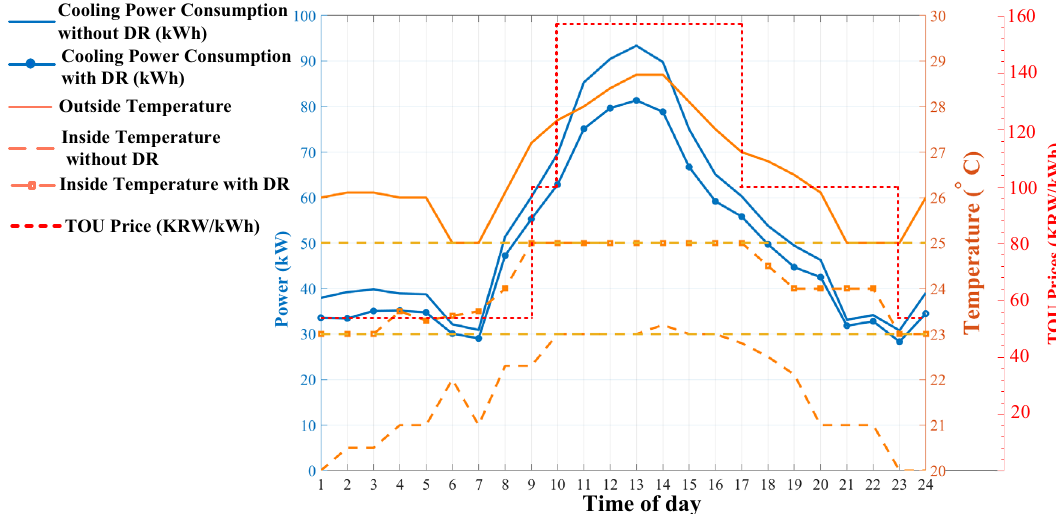
Figure 10. Cooling system power consumption with and without DR.